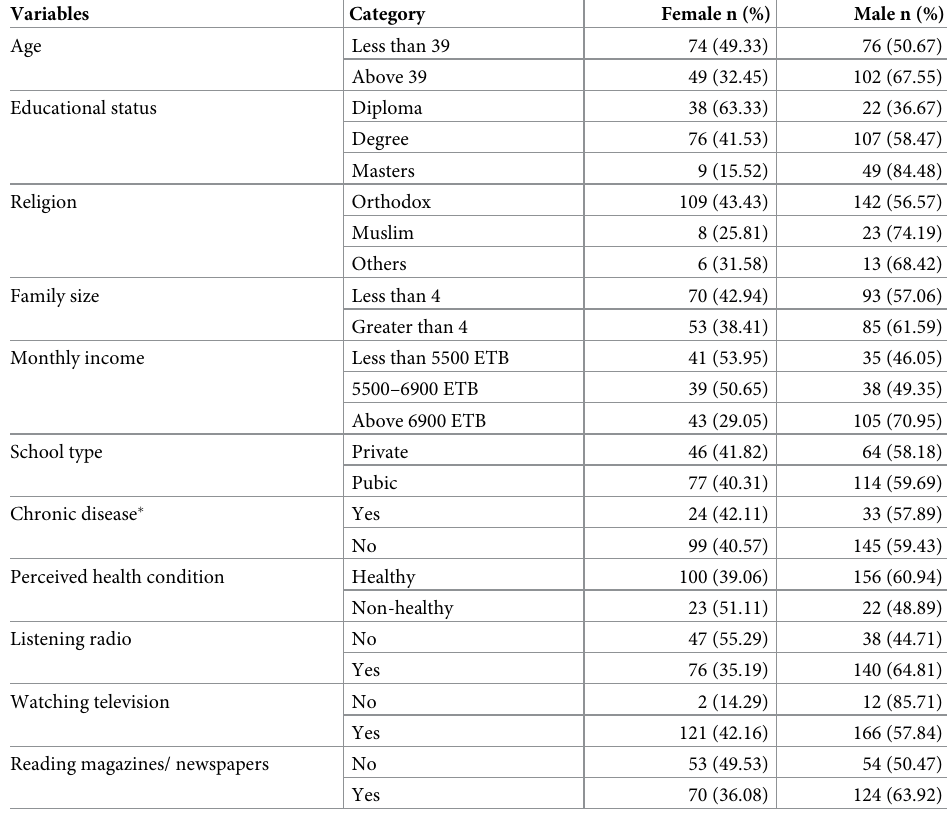
Table 1. Socio-demographic characteristics of school teachers in Gondar city, North West Ethiopia, 2021 (n = 301).